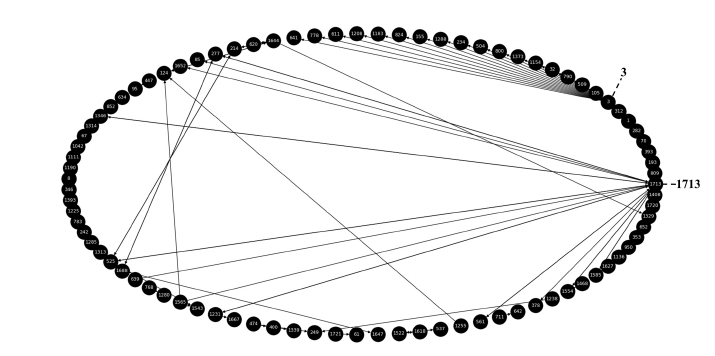
Figure 2. Mixing all 113 edges appear on 87 nodes on 27 June 2014. It is easy to find that nodes 1713 and 3 interact more frequently with other